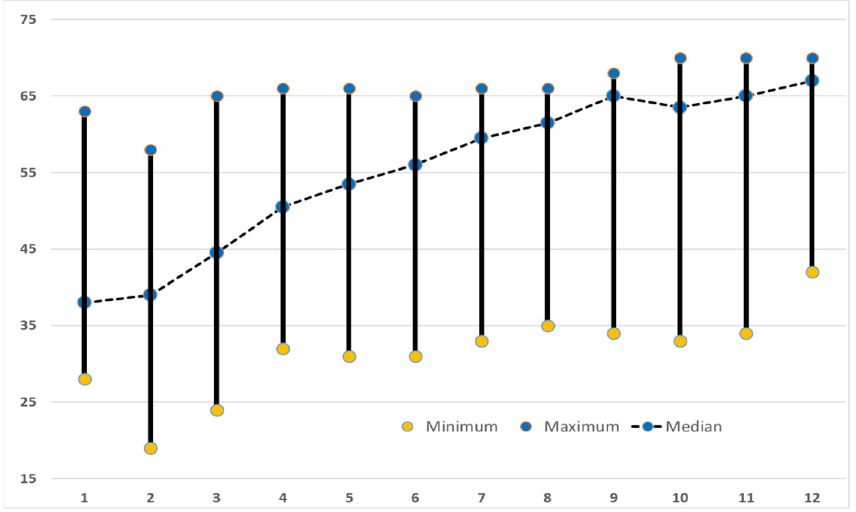
Figure 2. The median, maximum and minimum musical efficacy scores for the group of mentors over the 12 months of training ( n = 14).